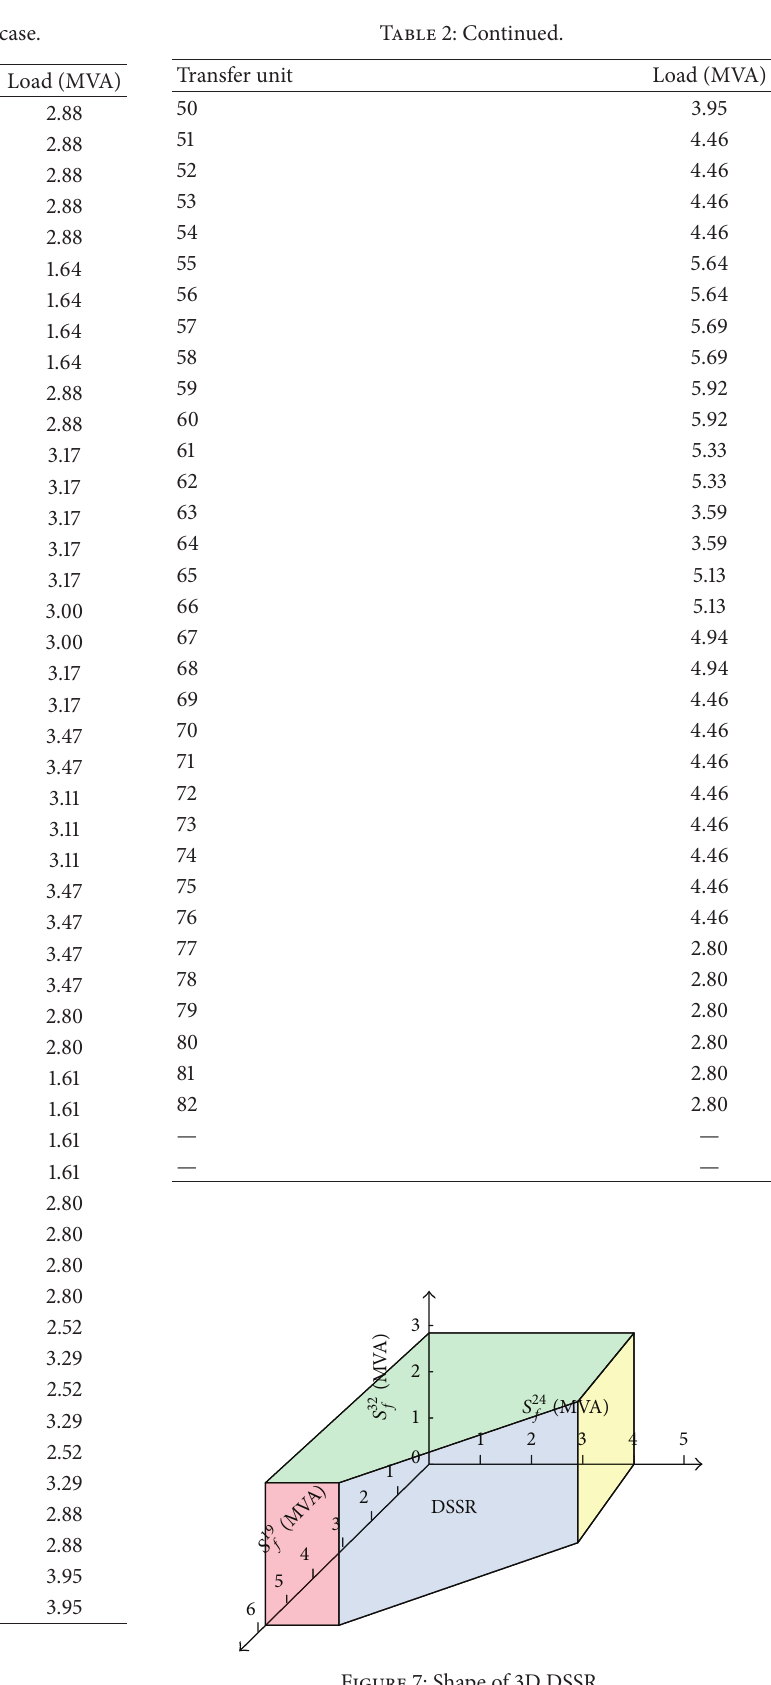
Figure 7: Shape of 3D